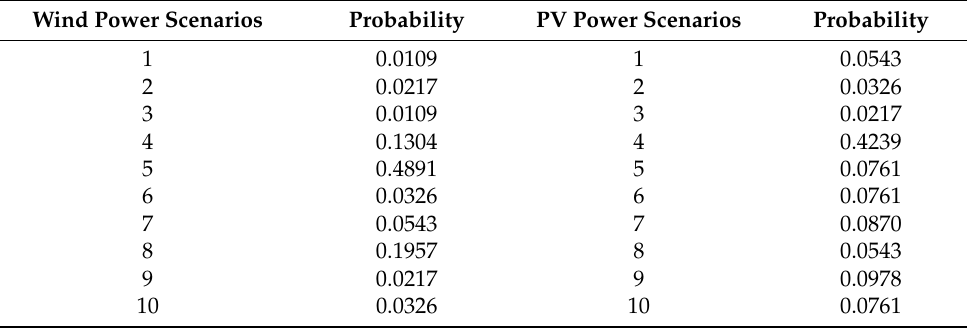
Table 3. Probabilities of ten sets of wind and PV power